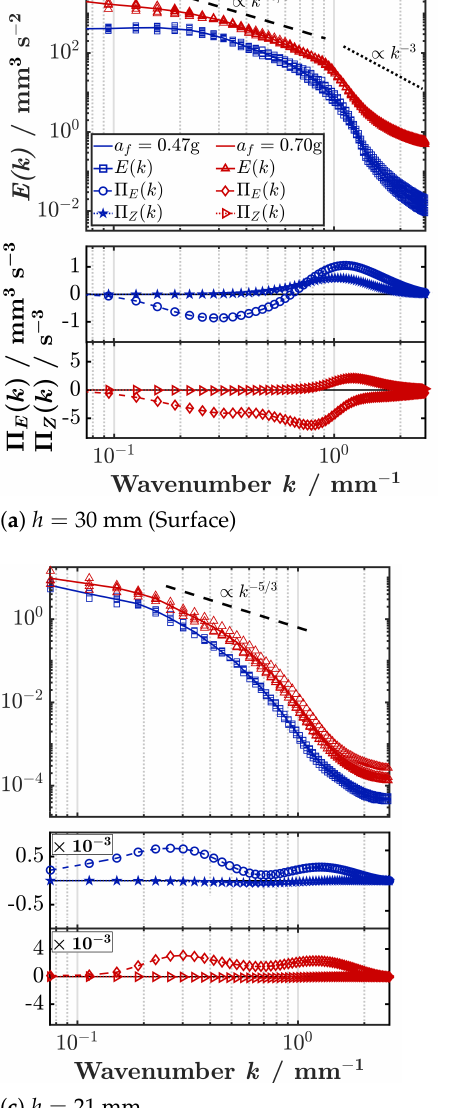
Figure 6. Wavenumber spectrum of flow kinetic energy, net energy fluxes and net enstrophy fluxes at different horizontal planes for forcing accelerations a f = 0.47 g and 0.70 g (blue and red). Results are averaged for all available time steps and measurement runs (4 or 6, Appendix A). Color